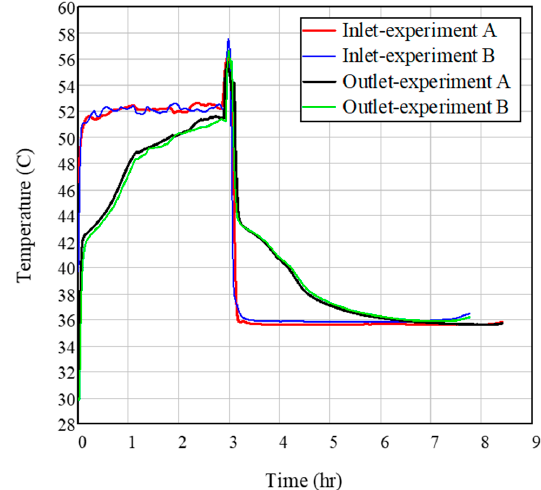
Figure 5. Comparison of the inlet and outlet water temperatures of the two same experiments A and B with 30 L/h flow rate.